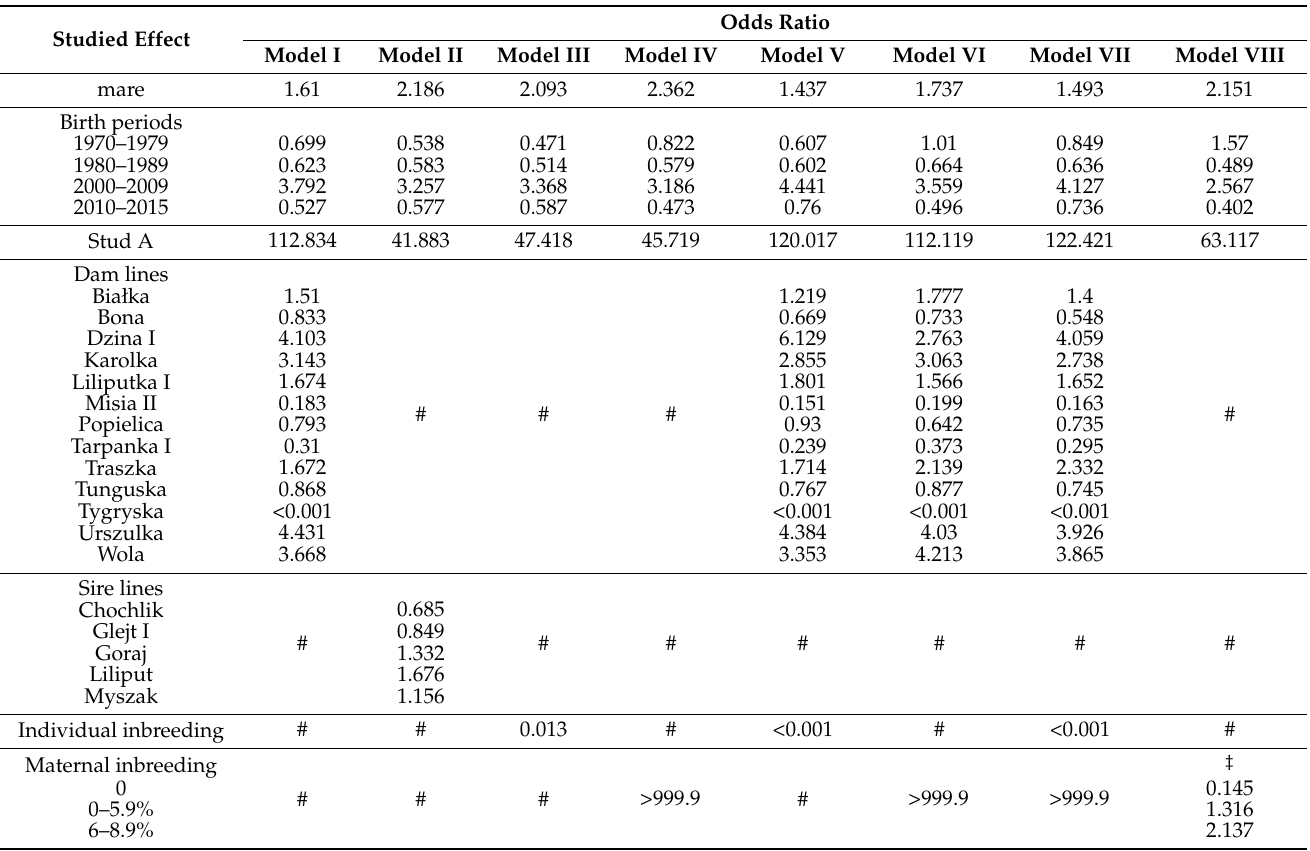
Table 6. Estimates of odds ratio for predisposition to asthma diseases.